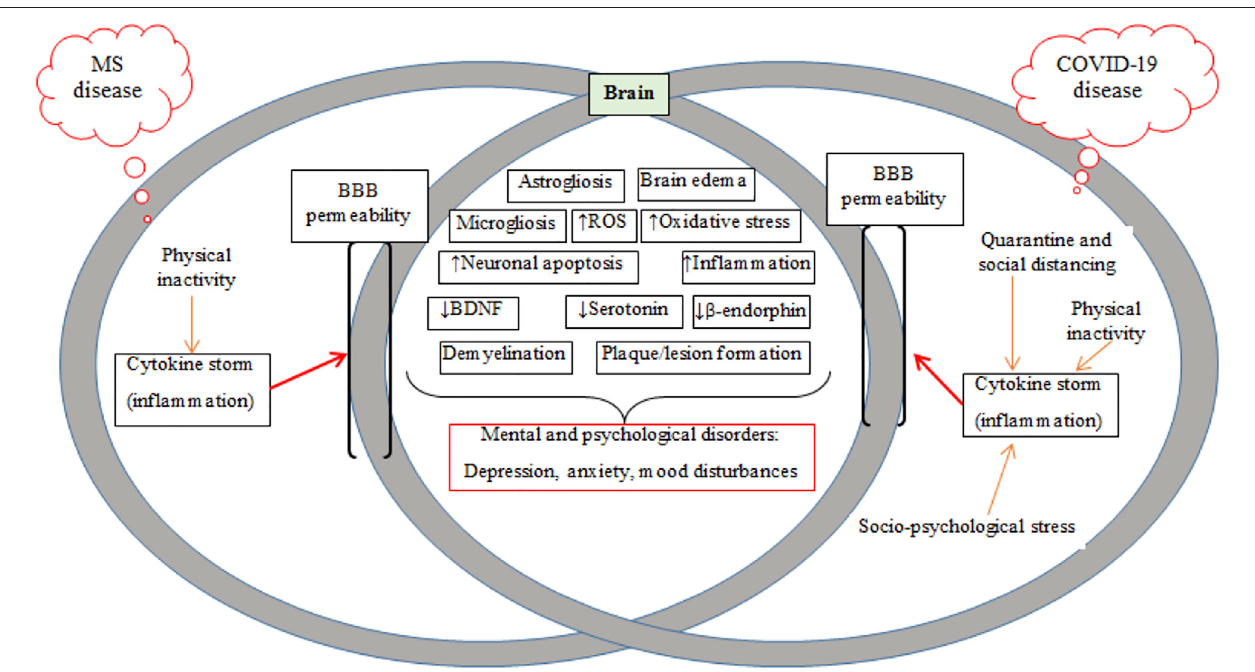
FIGURE 2 | Schematic of mechanisms common in MS and COVID-19 diseases, including BBB breakdown/permeability and mental and psychological disorders. MS, multiple sclerosis; BBB, blood-brain barrier; ROS, reactive oxygen species; BDNF, brain-derived neurotrophic factor.